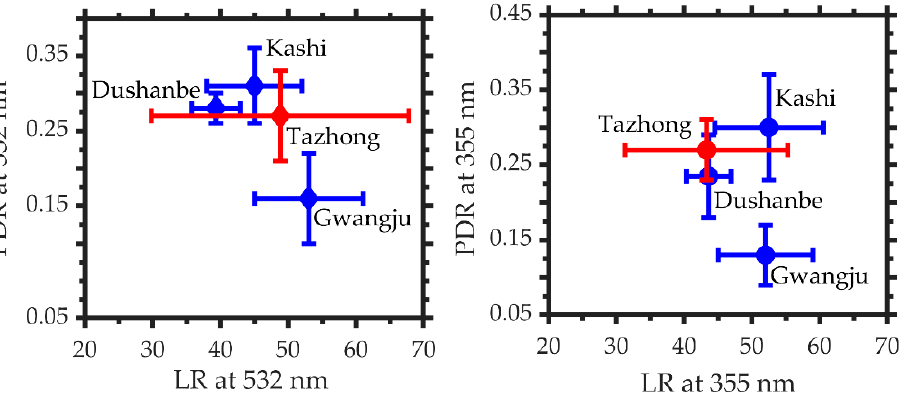
Figure 9. Relationship between dust LR and PDR at wavelengths of 355 and 532 nm, observed by multi-wavelength polarization Raman lidars in the current study and reported in the literature.